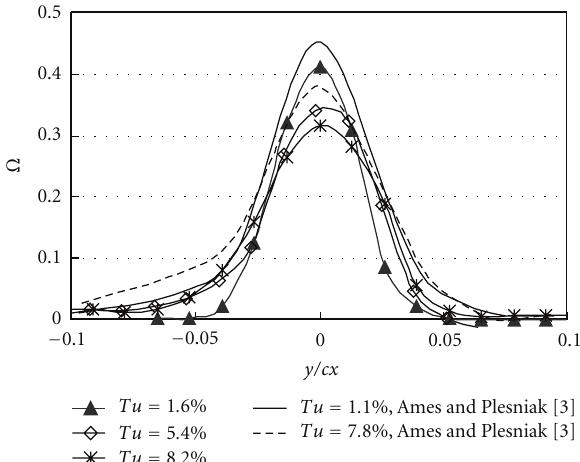
Figure 14: Comparison of vane wake total pressure loss coe ffi cient profiles with similar data from Ames and Plesniak [3]. The present data are measured 0.25 axial chord lengths downstream of a cambered vane with M ex = 0 . 35